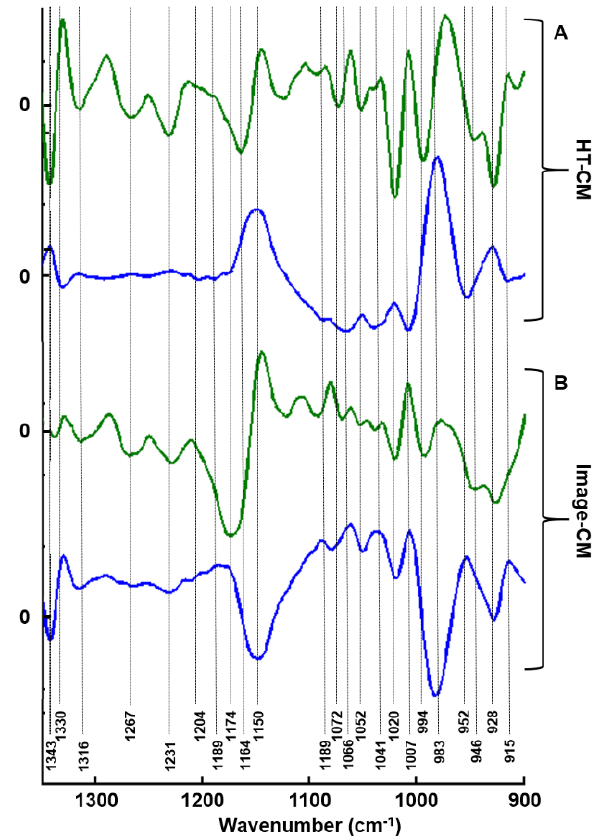
Figure 3. Comparison of first two principal components corresponding to: ( A ) high-throughput FTIR and ( B ) imaging spectra of GAGs extracted from CM. PC1 (blue line) and PC2 (green line).